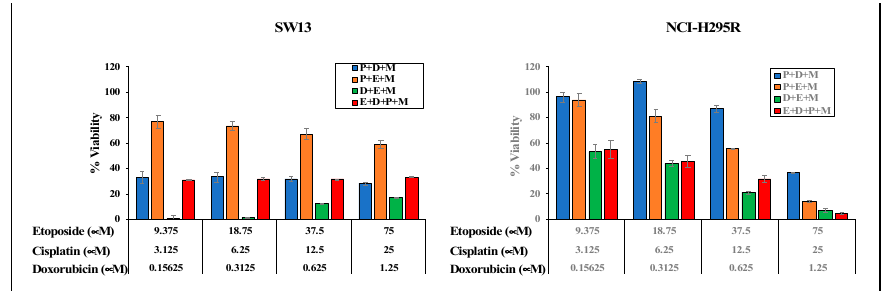
Figure 5. Comparison of viability of chemotherapeutic drug combinations (M + P + E or M + P + D or M + E + D) and Italian protocol (E + D + P + M) in NCI-H295R and SW13 cells.